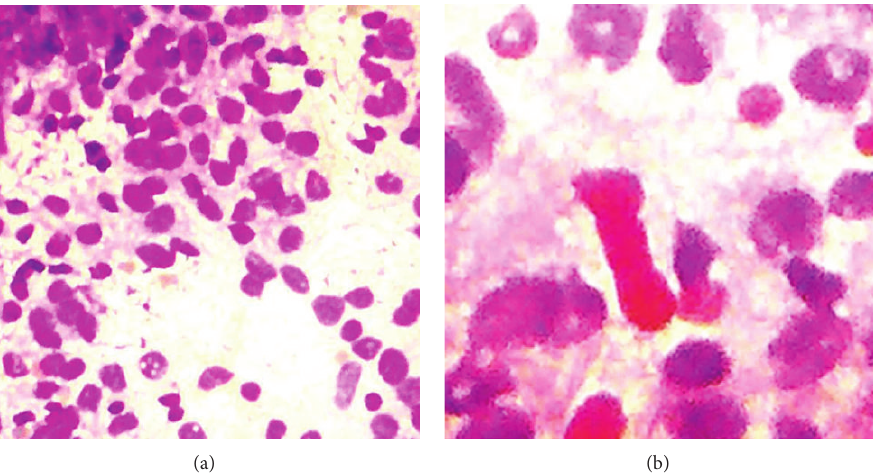
Figure 5: Histologic features of renal cell carcinoma; epithelial cellular network shown with clear cytoplasm and hyperchromatic nuclei surrounded by a rich vascular